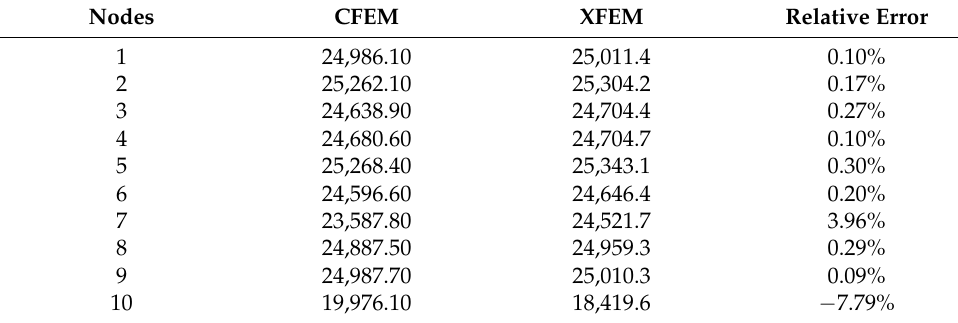
Table 2. Contrast of the results of nodes near interface.